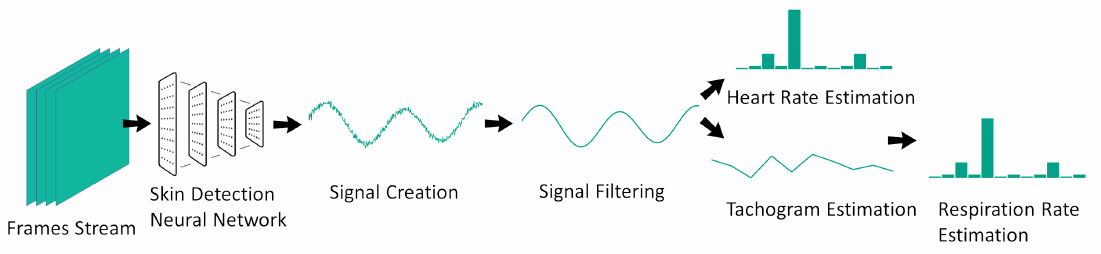
Figure 1. The proposed remote photoplethysmography (rPPG) method. The frame stream coming from the single-photon avalanche diode (SPAD) camera is first analyzed with a neural network that generates a signal further processed with classical